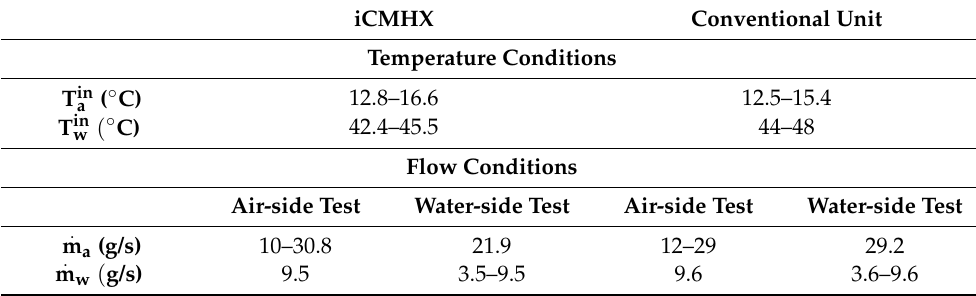
Table 2. Operating conditions for the